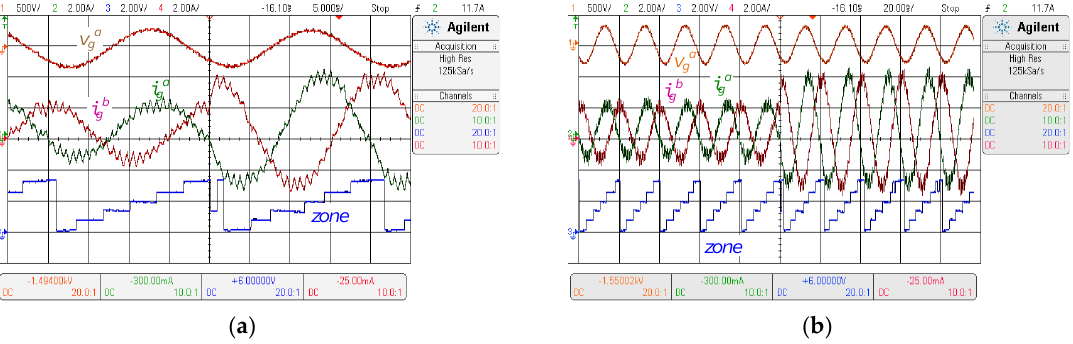
Figure 11. Current control step-up with f s = 1.2 kHz ( a ) zoom, ( b ) more periods.